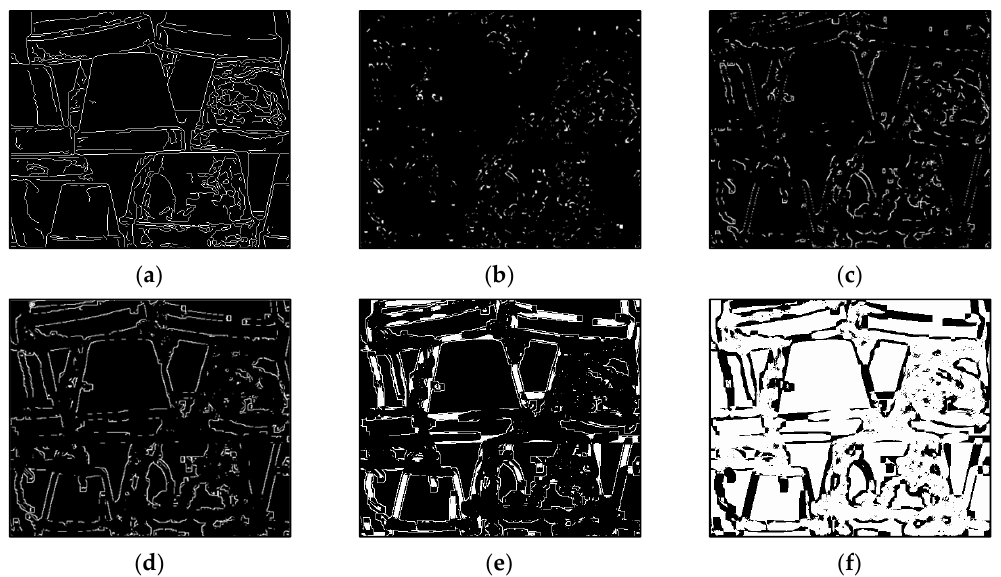
Figure 10. The results of Flowerpots by AWCT. ( a ) Edge information and schematic diagrams of the biggest window size in ( b ) 13 × 13, ( c ) 15 × 15, ( d ) 17 × 17, ( e ) 19 × 19, and ( f ) 21 × 21.